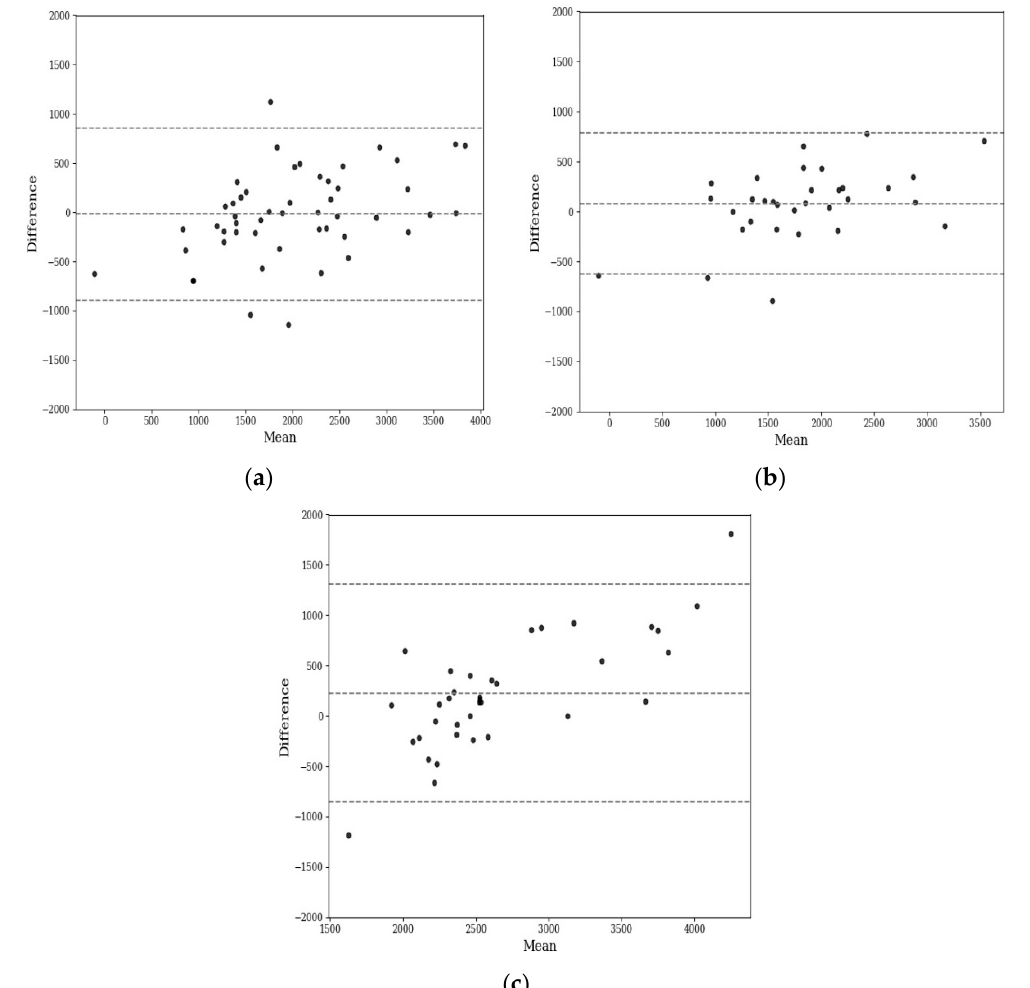
Figure 3. Bland–Altman plot for fat mass agreement between NIR (D2O as reference method) and the 4-compartment model for ( a ) all ages N = 164, ( b ) 0–6 months N = 105, and ( c ) 7–24 months N = 59.